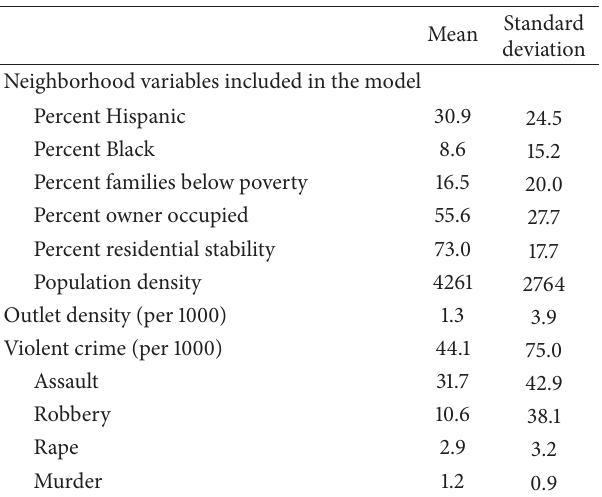
Table 1: Descriptive summary statistics for violent crime,